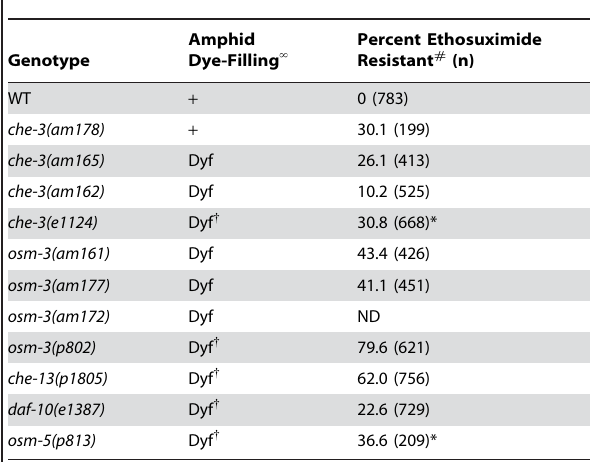
Table 1. Mutants with defects in cilia structure were resistant to ethosuximide